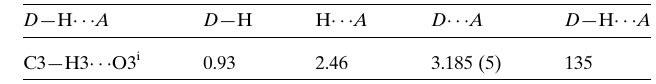
Table 1 Hydrogen-bond geometry (A˚ , (cid:2) ).